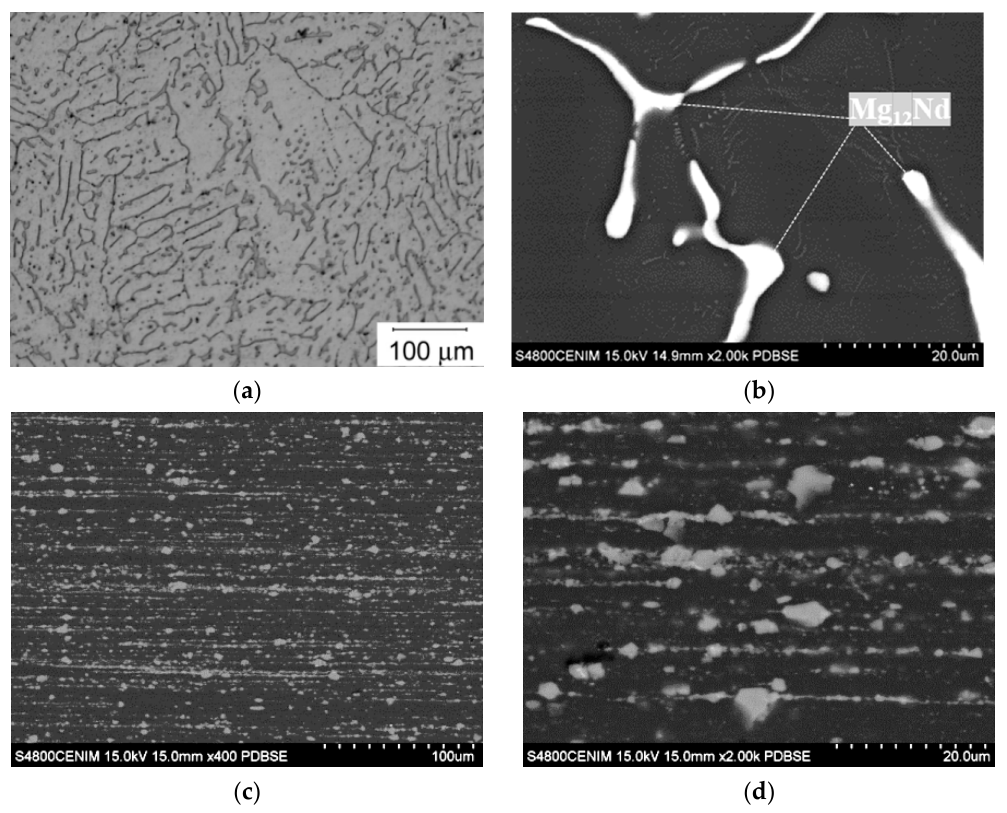
Figure 2. Optical micrographs showing the microstructure of EZ51 alloy. ( a , b ) As-cast ingot, ( c , d ) extruded bar.